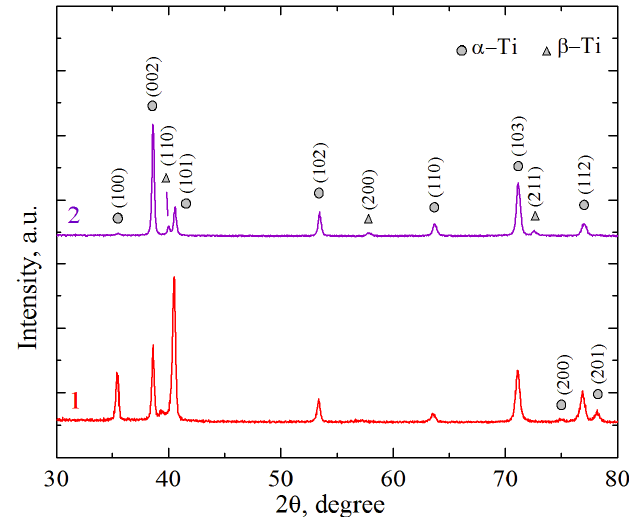
Figure 3. X-ray diffraction patterns of Ti-6Al-4V alloys with lamellar (1) and bimodal (2) microstructures.